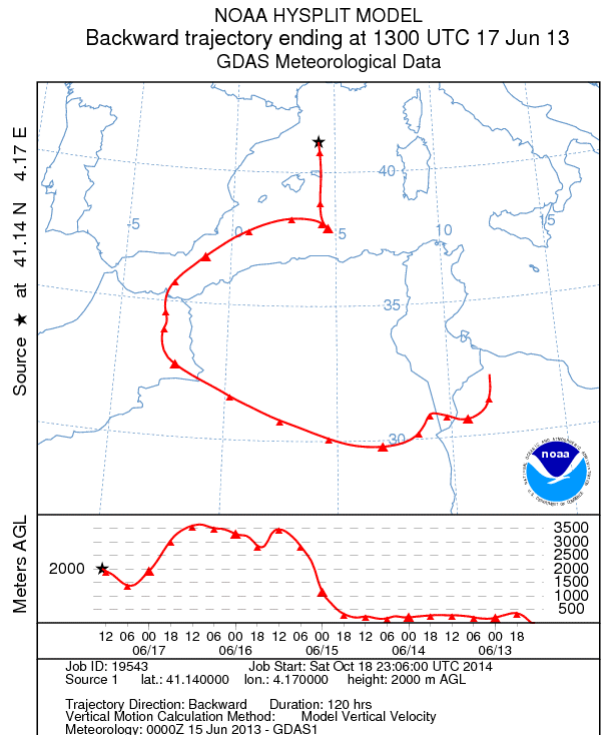
Figure 14. HYSPLIT air mass backward trajectory for LOAC bal- loon B75 (courtesy of NOAA Air Resources Laboratory).